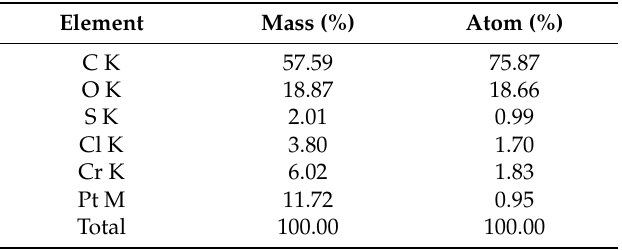
Table 3. Elemental content in bacterial biomass after treated with 100 mg / L Cr(VI).